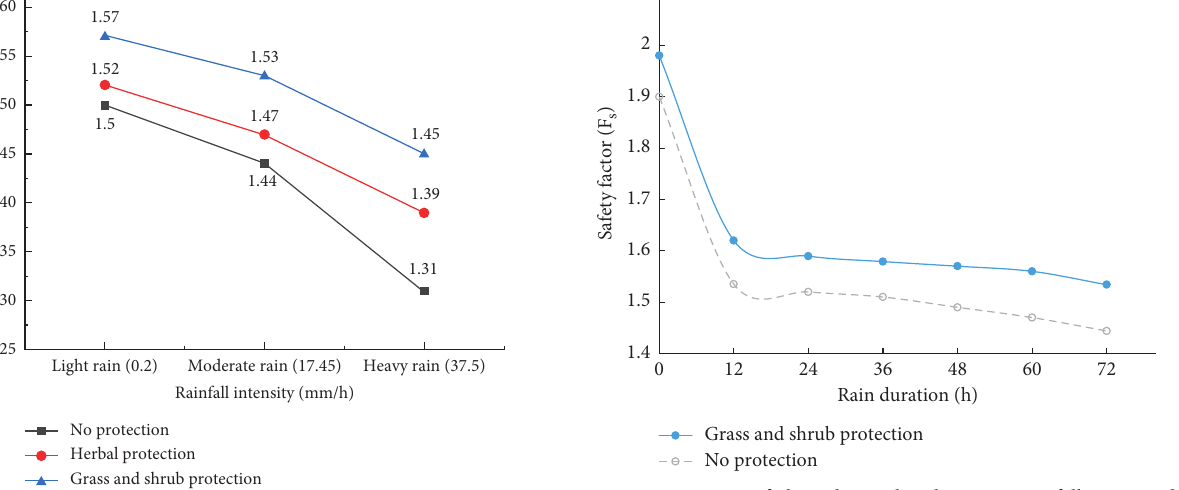
Figure 14: Curve of the relationship between rainfall intensity and safety factor.